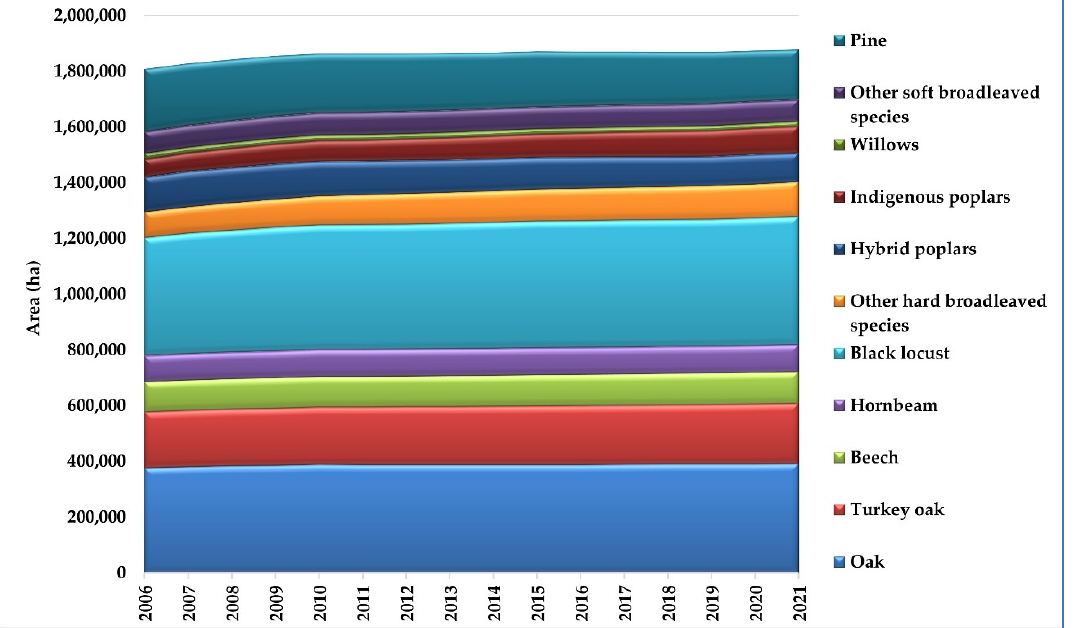
Figure 1. Evolution of the Hungarian forest area by tree species groups between 2006 and 2021.